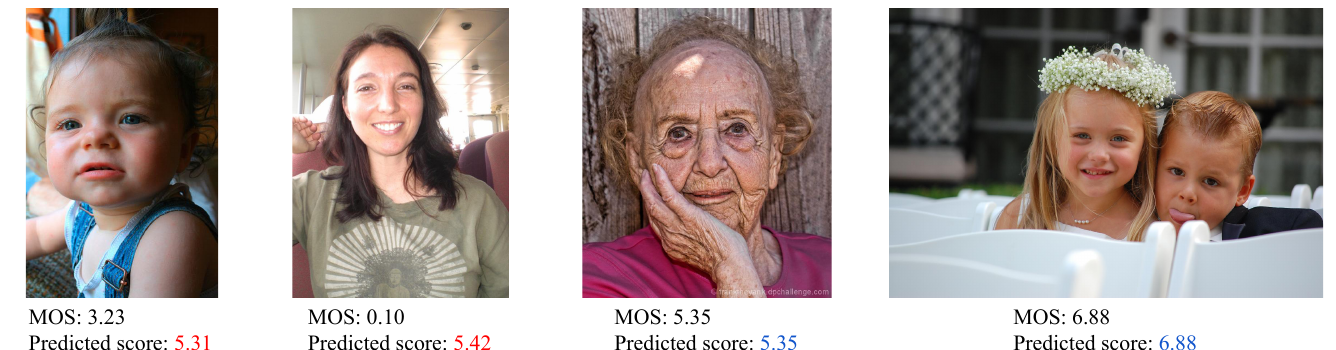
Figure 14. Images erroneously and correctly rated by our method GAwNorm-in-Norm trained on the whole image.